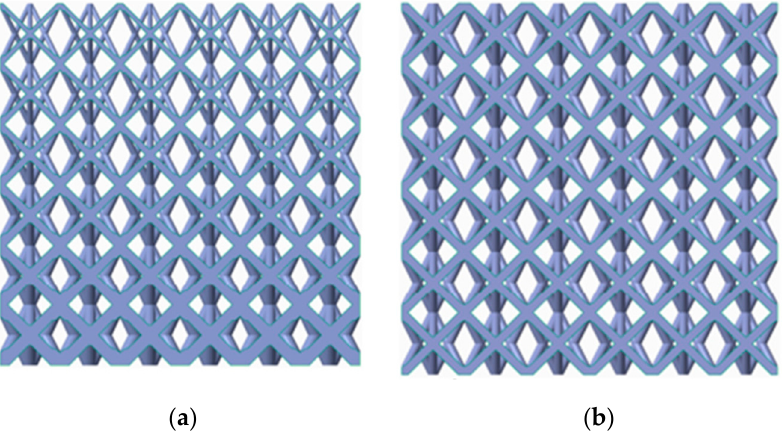
Figure 5. Lattice structures [90]: ( a ) grade; ( b ) uniform.